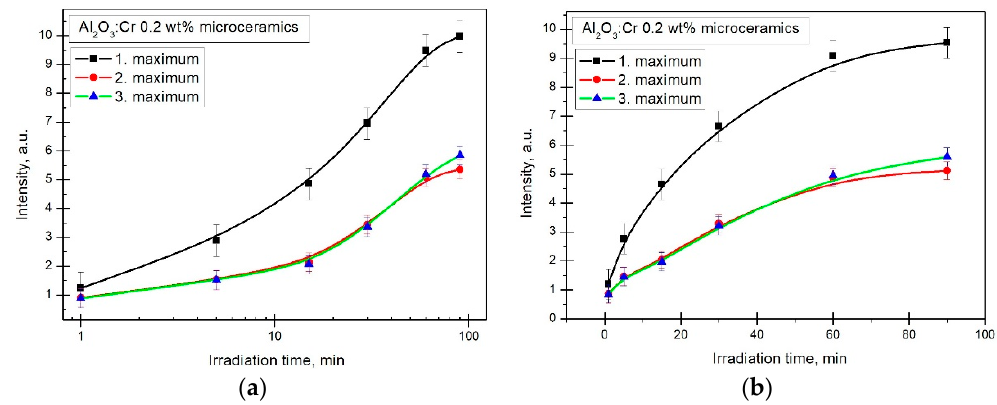
Figure 8. TL intensity dependence on irradiation time. ( a ) Results with a logarithmic time scale to illustrate that saturation and undersaturation has been achieved and ( b ) with a linear time scale to provide a more intuitive view.